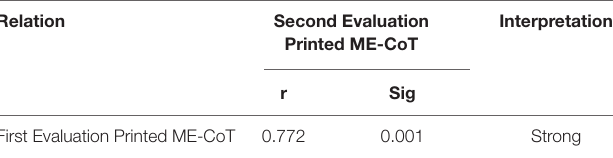
TABLE 8 | Pearson’s correlation coefficient index ME-CoT